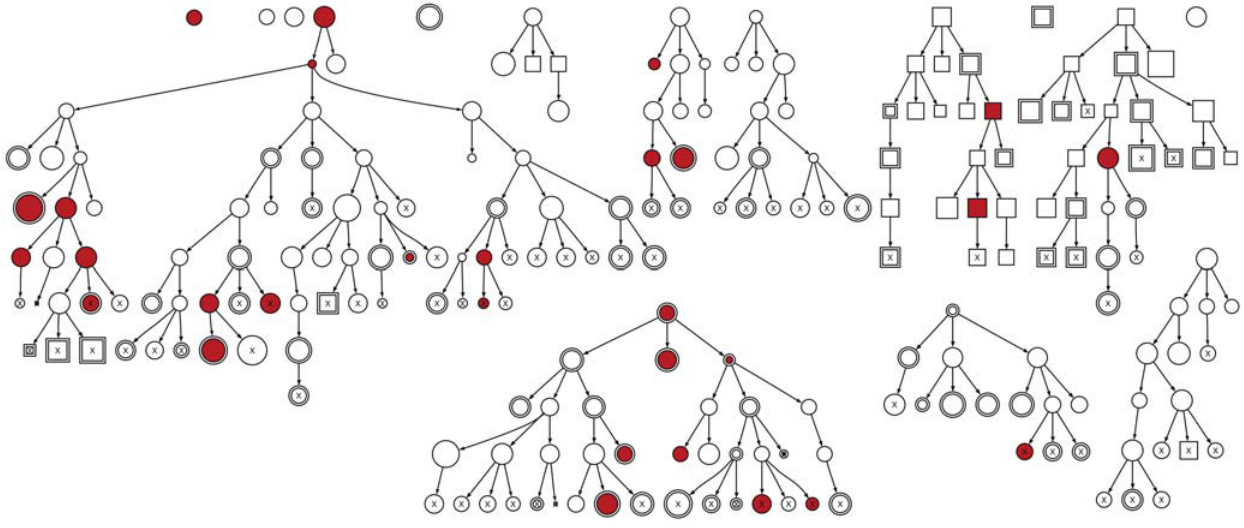
Figure 2. Referral trees from an RDS study of IDUs in Tijuana, Me´xico. Each node represents a respondent who recruits zero to three peers, indicated by arrows originating from the recruiter to the recruitee. The nodes are sized such that their diameter represents the respondent’s reported network size on a logarithmic scale (base 10). A cross-mark inscribed within the node indicates that the respondent was not given coupons to recruit at the end of the study. Node shape indicates the interview site (circle=Sepanal/Zona Norte, square=Camino Verde). A doubled perimeter indicates that the respondent reported injecting drugs at home. Shaded nodes represent respondents who tested seropositive for syphilis.